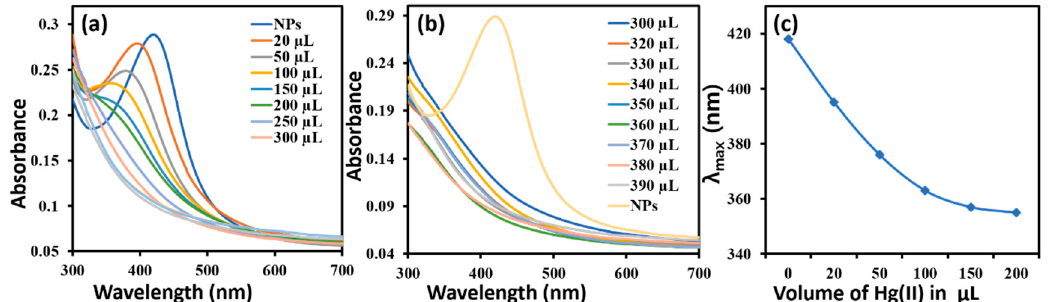
Figure 5. UV–vis spectra of AgNPs with ( a ) 20–200 µL of Hg 2+ , ( b ) 300–400 µL of Hg 2+ , and ( c ) variation of λ max on addition of Hg 2+ solution.